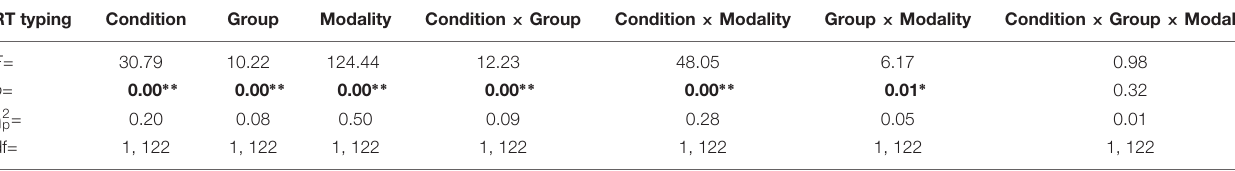
TABLE 5 | ANOVA results for reaction time (RT) of the typing